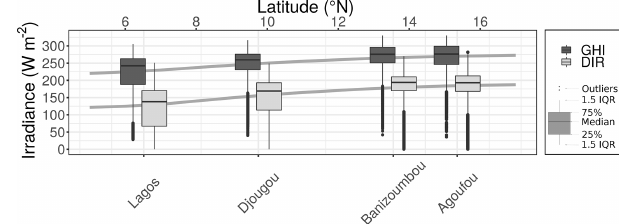
Figure 7. Median daily global (dark gray) and direct horizontal irradiance (light gray) from the SARAH-2.1 data set at Agoufou, Mali; Banizoumbou, Niger; Djougou, Benin; and Lagos, Nigeria as a function of latitude. The variability is illustrated by the box plots, showing the interquartile range and whiskers. The gray line connects the mean GHI (top) and DIR (bottom) over each latitude of the study